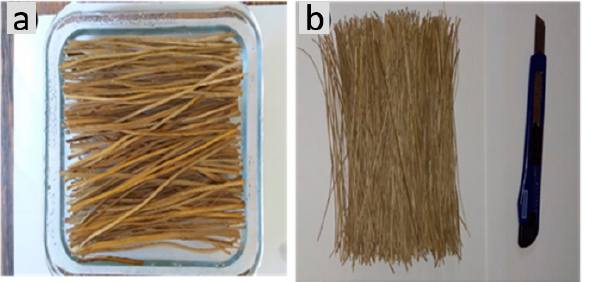
Figure 2. Extraction process of TVFs: ( a ) roots in water-immersed splints; ( b ) manual extraction of the fibers.